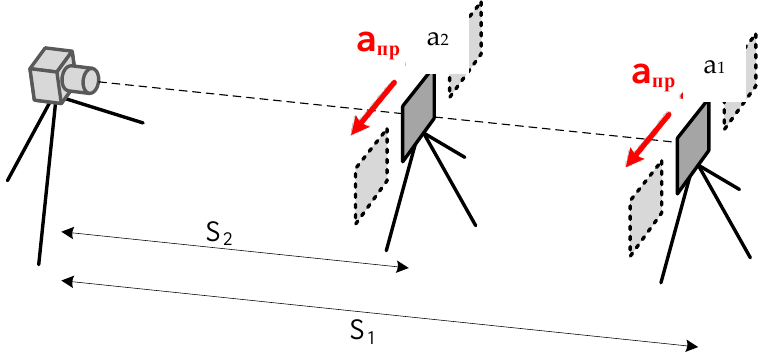
Figure 18. The VOS single-chain simulation scheme.